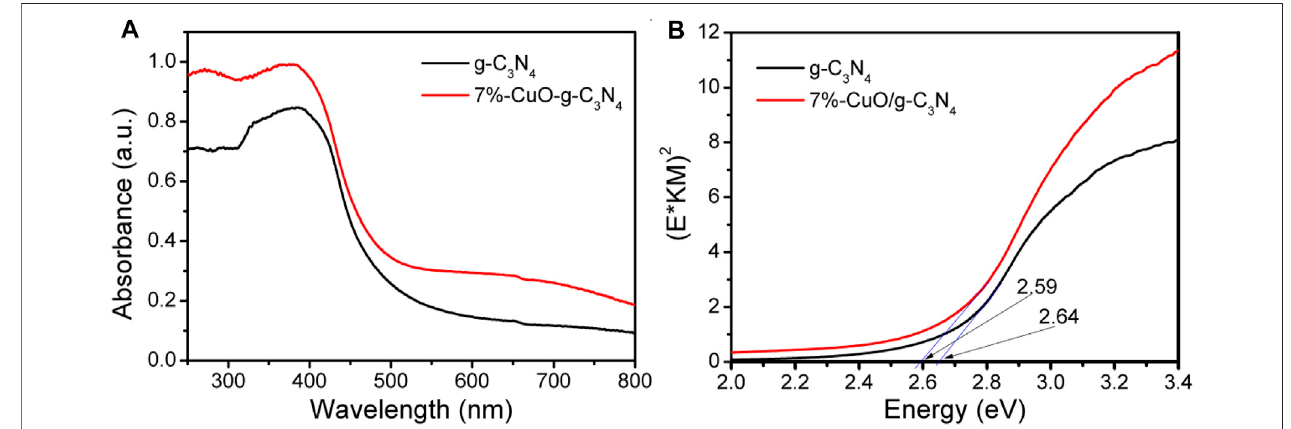
FIGURE 2 | Ultraviolet-visible diffused re fl ectance spectra (UV-Vis DRS) of g-C 3 N 4 and 7%-CuO/g-C 3 N 4 samples.